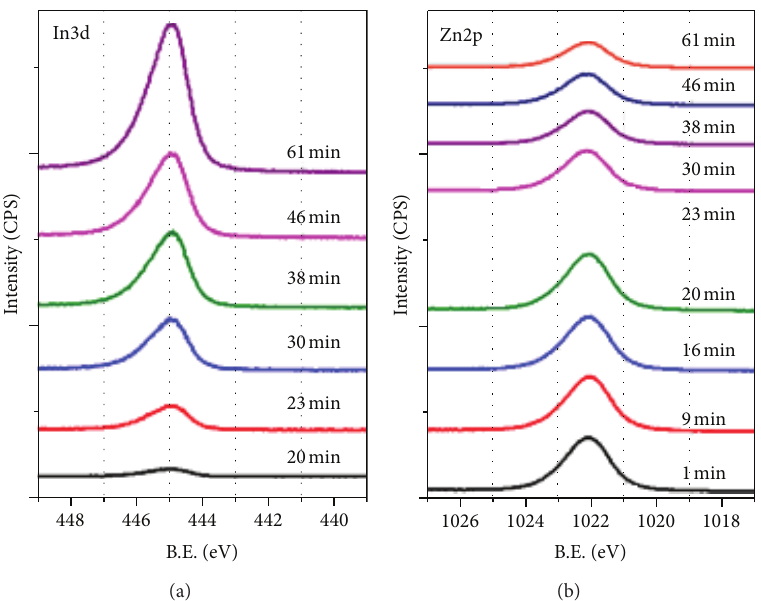
F 8: �PS spectrum in the In3d and Zn2p reigns for n-ITO/n-ZnO isotype heterojunction under various pro�ling time.